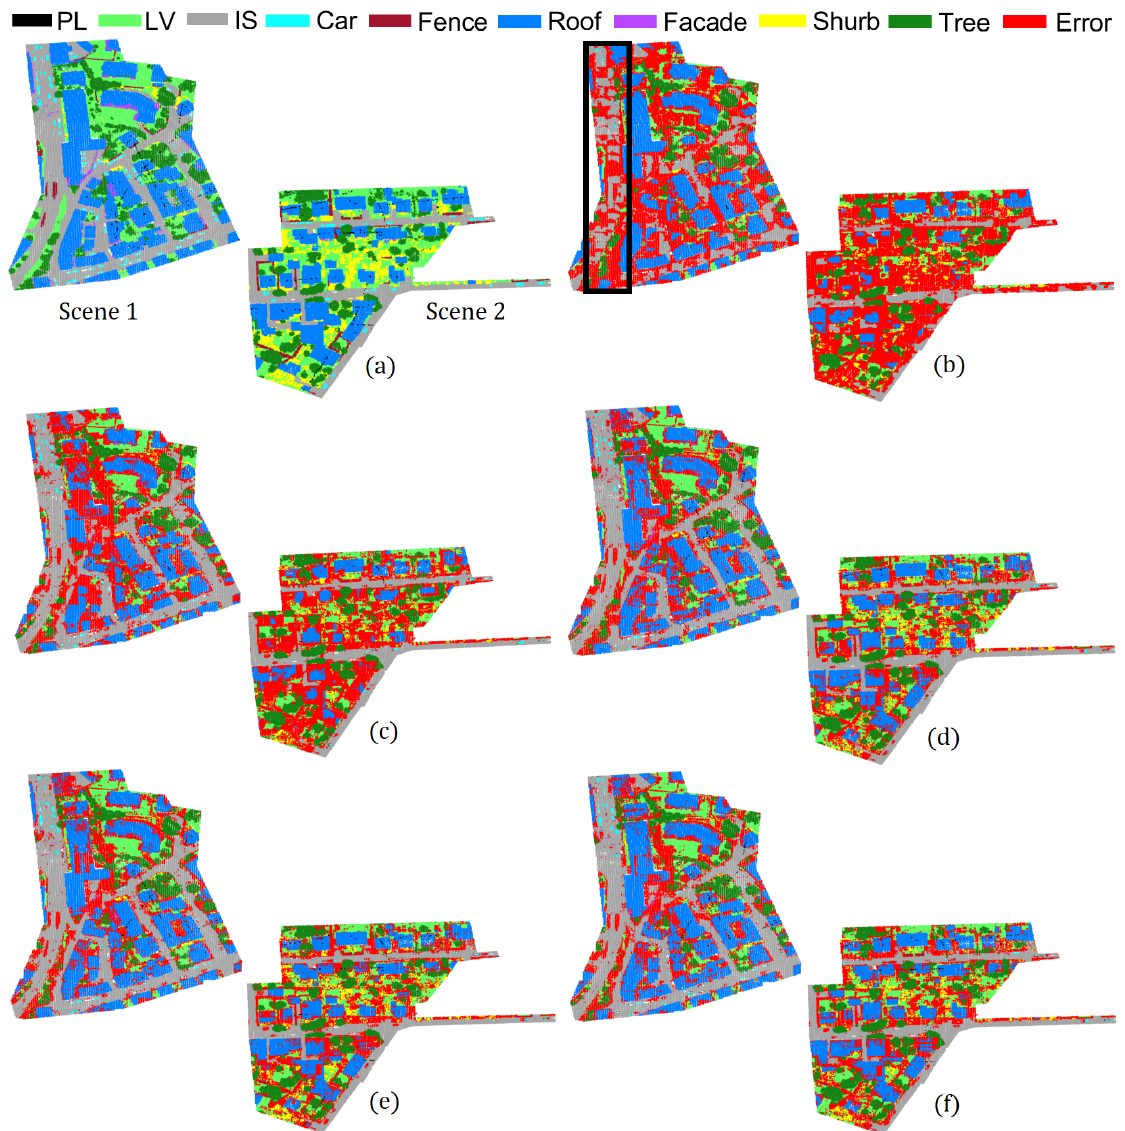
Figure 3: Vaihingen test data set, (a) ground-truth; classification results for the inputs (b) Group 1; (c) Group 2; (d) Group 3; (e) Group 4; (f) Group 6. Results in the black rectangle in (b) show that many points of the impervious surface, fence and low vegetation are misclassified (red). Misclassifications for the same part are almost similar in the figures (e) and (f), but significantly better than (b).